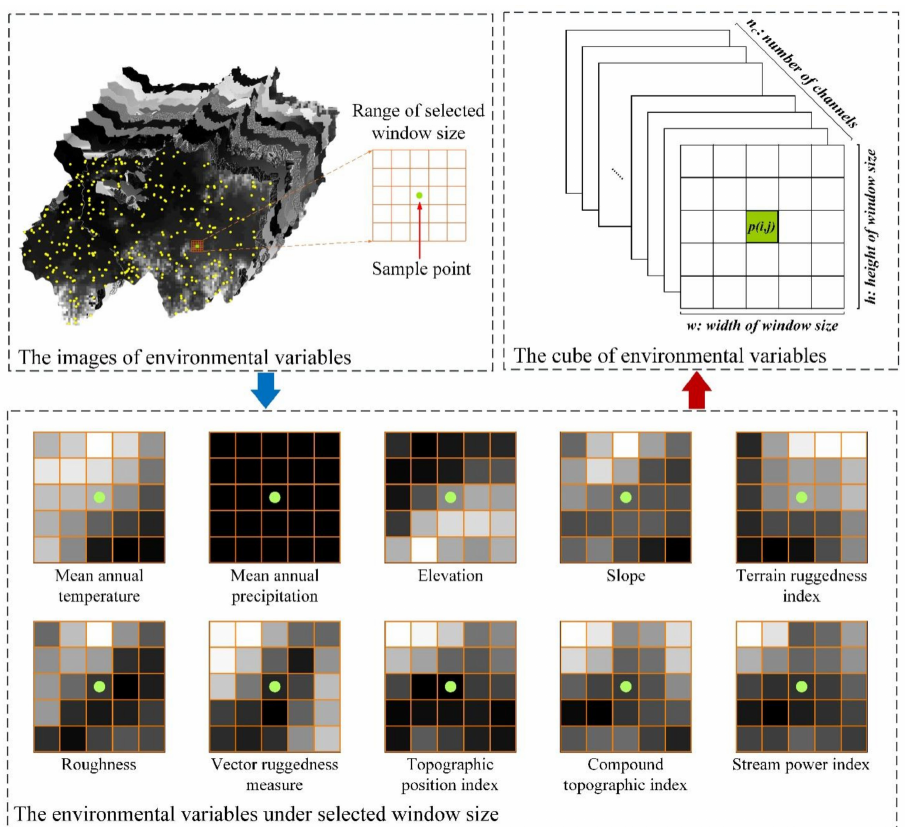
Figure 4. The contextual spatial information of climate and topographic covariates as the input supplied to the convolutional neural network (CNN)